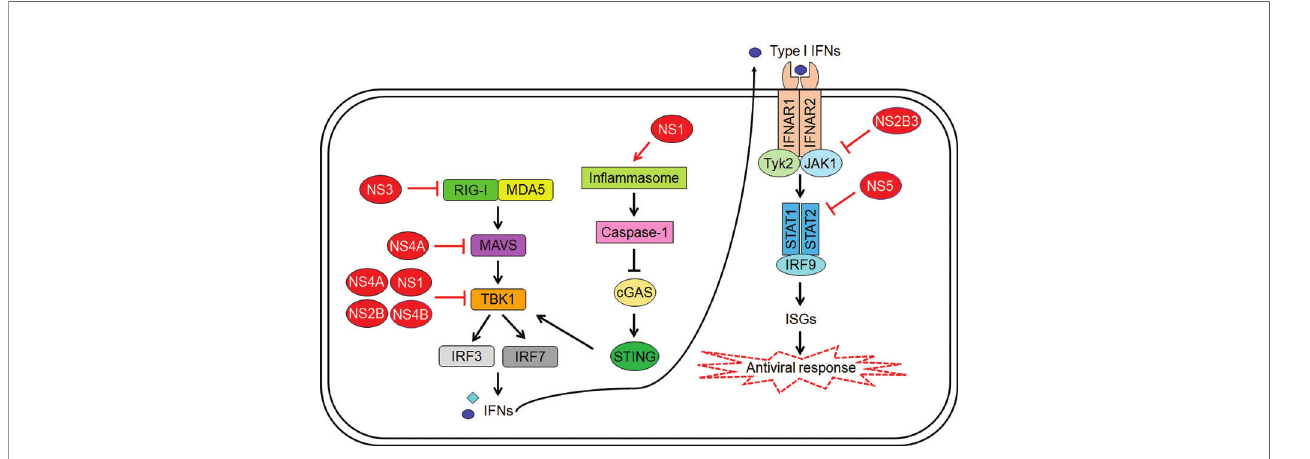
FIGURE 1 | Zika virus (ZIKV)-mediated inhibition of host innate immunity. The viral proteins indicated in red color interfere with signalling pathways at multiple steps leading to suppression of type I interferon (IFN) induction as well as IFN-mediated expression of IFN-stimulated genes